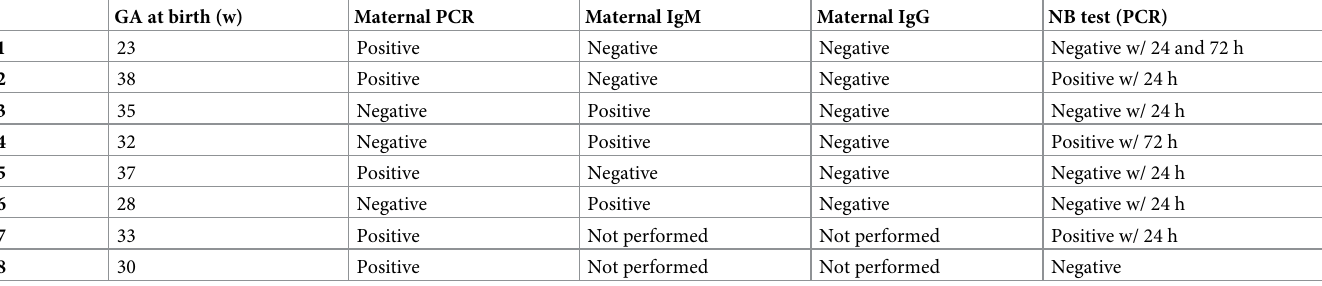
Table 6. RT-PCR tests performed in newborns and the correlation with maternal test results (N = 8). GA at birth